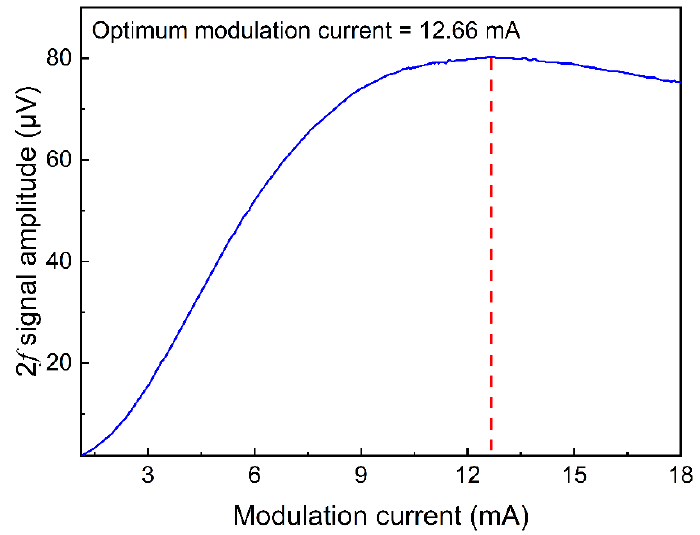
Figure 6. IP-SQEDS signal amplitude as a function of modulation current depth (H 2 O concentration was 1.73%).